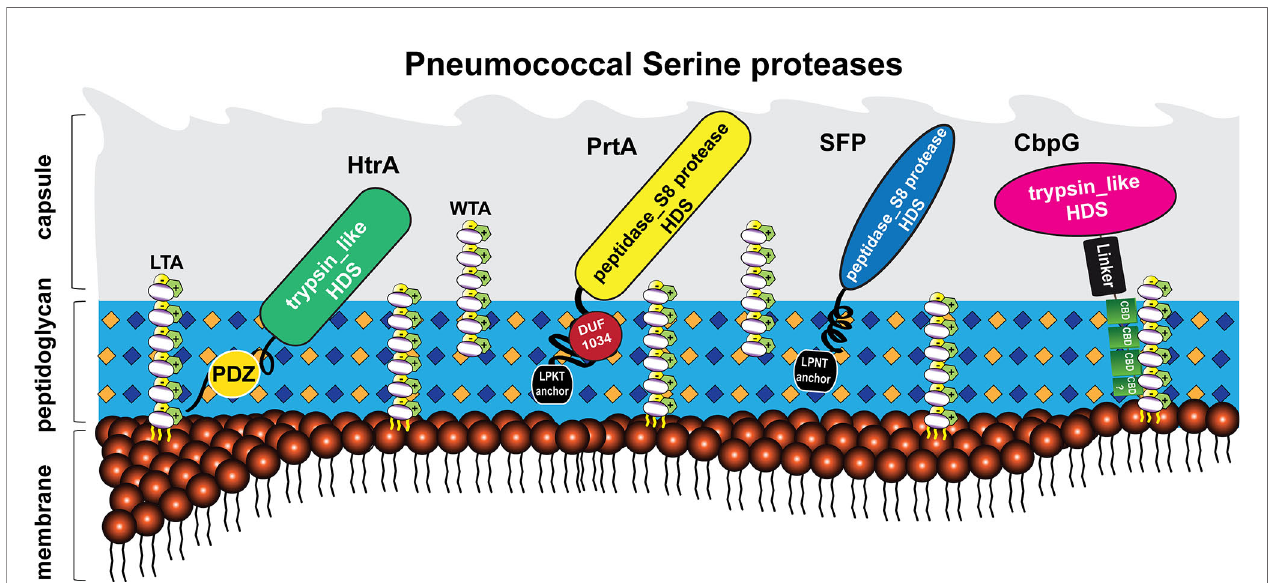
FIGURE 1 | Localization of pneumococcal serine proteases on the bacterial surface. The pneumococcal cell wall of S. pneumoniae contains four different classes of surface-exposed proteins: choline-binding proteins (CBPs), sortase-anchored proteins containing a C-terminal LPXTG motif, lipoproteins, and non-classical surface proteins (Gamez and Hammerschmidt, 2012; Pribyl et al., 2014; Kohler et al., 2016). These proteins are associated with different structures of the cell wall, consisting of peptidoglycan (light blue), wall teichoic acids (WTA) and lipoteichoic acids (LTA) (carbohydrates repeating units in white circles for WTA and LTA). Wall teichoic acids are directly linked to the peptidoglycan (PGN), lipoteichoic acids are anchored to the phospholipid bilayer (membrane) via a lipid anchor (Tomasz, 1967). Pneumococcal teichoic acids are decorated with phosphorylcholine ( PCho ) residues (McCullers and Tuomanen, 2001). The pneumococcus displays four serine proteases on the bacterial surface (Mann et al., 2006; de Stoppelaar et al., 2013). Choline-binding protein G (CbpG, pink); bound non-covalently via the conserved choline-binding repeats (CBRs; green) to the phosphorylcholine residues of WTA or LTA. Subtilase family protein (SFP, blue) and cell wall-associated serine proteinase (PrtA, yellow) belong to the subtilisin-like proteases. Both proteins contain an N-terminal signal peptide and a C-terminal LPXTG motif. The latter is necessary to bind SFP and PrtA to the PGN, catalyzed by the transpeptidase Sortase A. High-temperature requirement A (HtrA, green) belongs to the family of trypsin-like proteases and contains no speci fi c cell wall anchoring motif. All of these proteins contain the catalytic active domain with the Asp-His-Ser triad, which has proteolytic